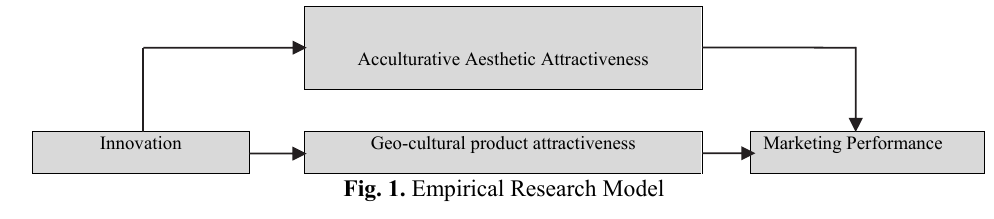
Fig. 1. Empirical Research